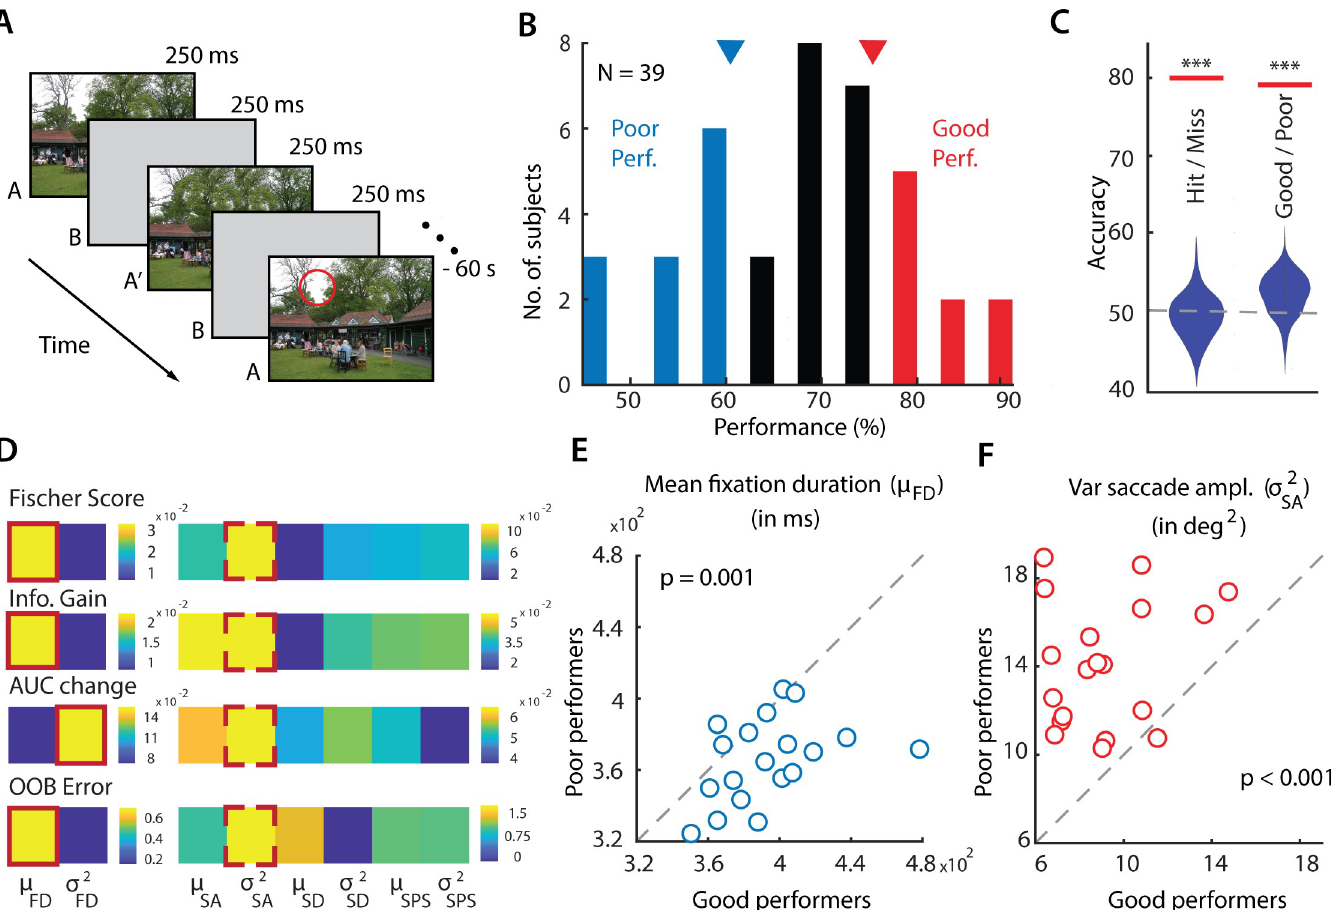
Fig 1. Gaze metrics predict success in a change blindness experiment. A. Schematic of a change blindness experiment trial, comprising a sequence of alternating images (A, A’), displayed for 250 ms each, with intervening blank frames (B) also displayed for 250 ms (“flicker” paradigm), repeated for 60 s. Red circle: Location of change (not actually shown in the experiment). All 20 change image pairs tested are available in Data Availability link. B. Distribution of success rates of n = 39 participants in the change blindness experiment. Red and blue bars: good performers (top 30 th percentile; n = 9) and poor performers (bottom 30th percentile; n = 12), respectively. Inverted triangles: Cut-off values of success rates for classifying good (red) versus poor (blue) performers. C. Classification accuracy, quantified with area- under-the-curve (AUC), for classifying trials as hits versus misses (left horizontal line) and performers as good versus poor (right horizontal line), obtained with a support vector machine classifier. Violin plots: Null distributions of classification accuracies based on a permutation test ( ��� p < 0.001). Error bars: Clopper-Pearson binomial confidence intervals. D. Feature selection measures for identifying the most informative features that distinguish good from poor performers. From top to bottom: Fisher score, Information gain, Change in area-under-the-curve (AUC) and bag of decision trees (for details, see Feature Selection Metrics in the Materials and Methods). Brighter colors indicate more informative features. Solid red outline: most informative feature in the fixation feature subgroup (left); dashed red outline: most informative feature in the saccade feature subgroup (right). FD—fixation duration, SA—saccade amplitude, SD—saccade duration, SPS—saccade peak speed. μ and σ 2 denote mean and variance of the respective parameter. E. Distribution of mean fixation duration ( μ FD , in milliseconds) across 19 change images for good performers (x- axis) versus poor performers (y-axis); one change image pair, successfully detected by all performers, was not included in these analyses (see text). Each data point denotes average value of μ FD , across each category of performers, for each image tested. Dashed diagonal line: line of equality. p-value corresponds to significant difference in mean fixation duration between good and poor performers. F. Same as in E, but comparing variance of saccade amplitudes (in squared degrees of visual angle) for good versus poor performers. Other conventions are the same as in panel